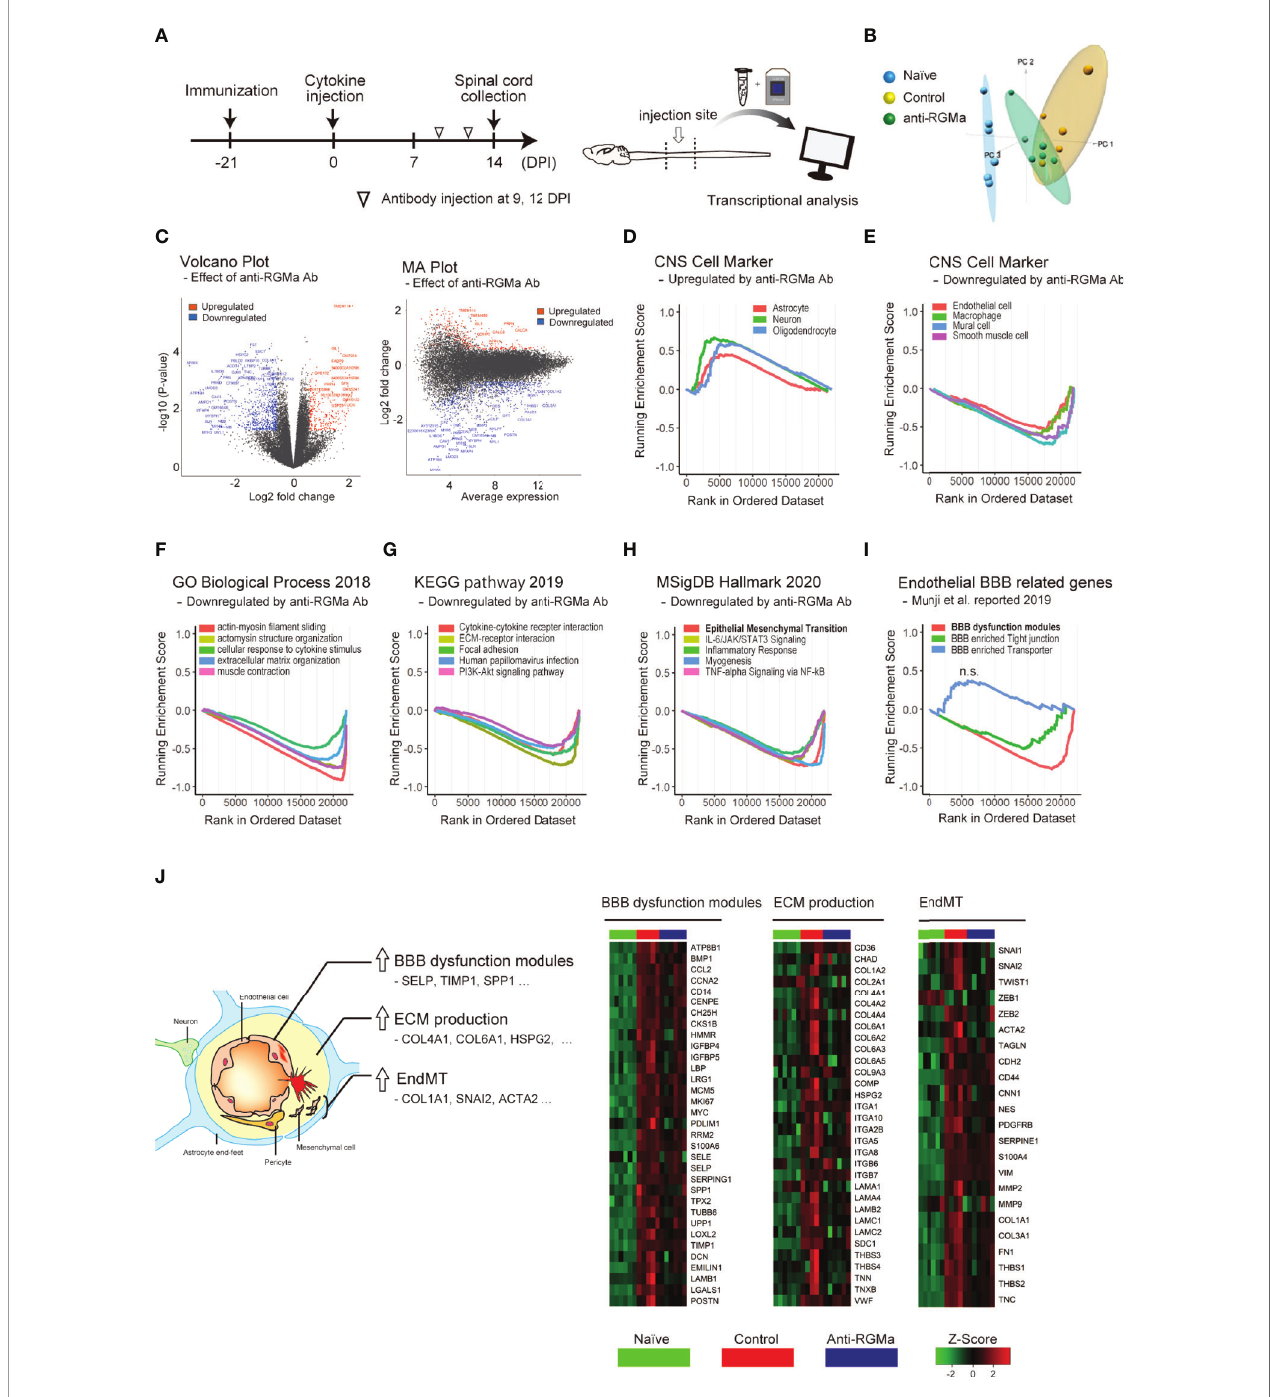
FIGURE 5 | Transcriptional analysis of targeted EAE mice treated with control/anti-RGMa antibody. (A) Graphical representation of transcriptional analysis experiments. (B) Principal component analysis plot of each group. (C) Volcano plot (left) and MA plot (right) of the comparison between the isotype control group and the anti-RGMa antibody group. Differentially expressed genes (fold change>1.5, p -value < 0.05) were represented by color dots. (D) GSEA plot of CNS cell markers with positive enrichment in anti-RGMa antibody group compared to isotype control group ( p -adjust < 0.05). (E) GSEA plot of CNS cell markers with negative enrichment in anti-RGMa antibody group compared to isotype control group ( p -adjust < 0.05). (F – H) Top 5 GSEA plots with negative enrichment gene sets ( p -adjust < 0.05) of GO biological process (F) , KEGG pathway (G) , and MsigDB hall mark (H) . (I) GSEA plot of BBB related genes sets ( p -adjust < 0.05, n.s.; not signi fi cant). (J) Key features related to BBB disruption and corresponding genes (left) and heatmap of representative genes in BBB dysfunction modules, ECM production, and EndMT